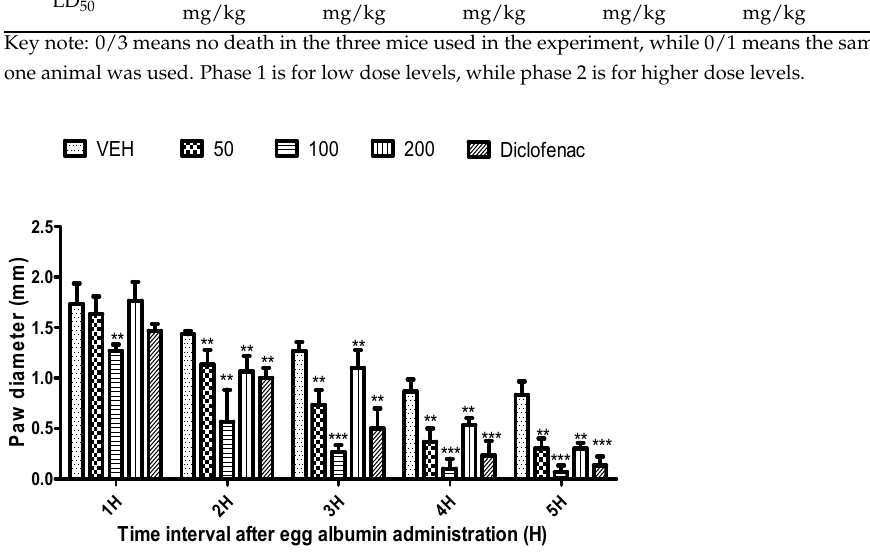
Figure 2. Effect of “White Marsh” grapefruit ( C. paradisi ) fresh leaf essential oil on egg albumin- induced rat paw oedema. Results are expressed as Mean ± SEM. VEH, ECH and ASA represent vehicle (5% Tween 80), Marsh leaves essential oil (FMLG) and diclofenac, respectively. * p < 0.05, ** p < 0.01 and *** p < 0.001, statistically different from negative control group (ANOVA, Dunnett’s). 1 H